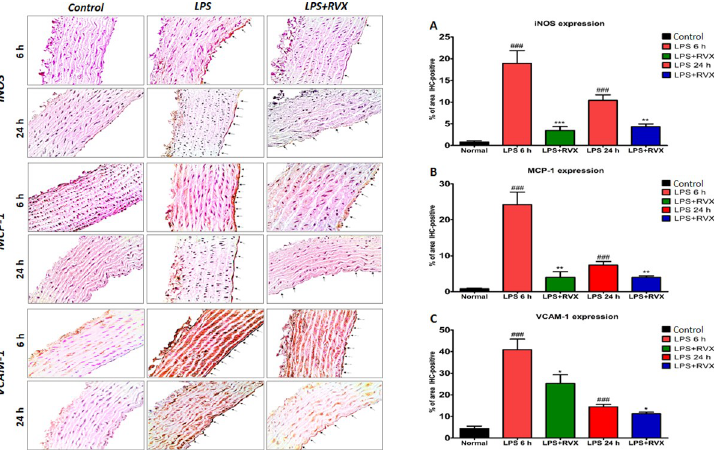
Fig 3. Role of RVX pre-treatment on LPS induced proinflammatory and proadhesive mediator’s protein expression in rat aorta. Representative immunohistochemical results for aortic iNOS (A), MCP-1 (B) and VCAM-1 (C) expressions from RVX- or non-treated LPS rats and non-treated control rats as described in the legend. % of IHC positive areas are represented as graphs. ### indicates values significantly different (Student’s t-test) vs. control conditions. � P < 0.05, �� P < 0.01 and ��� P < 0.001 indicates values significantly different (Student’s t-test) vs LPS. Values are expressed as the mean ± SEM (n = 6).